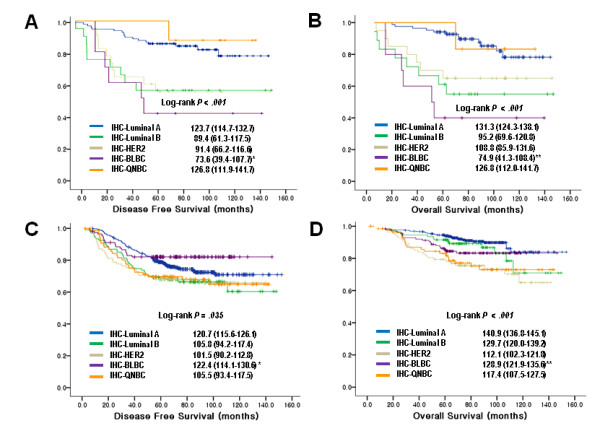
Association between chemotherapy and five-subtypes of breast cancers. Kaplan-Meier curves of disease-free survival (A and C) and overall survival (B and D). Cases without chemotherapy (A and B) and with chemotherapy (C and D) (Estimated mean survival with 95% CI). *P = 0.001, **P < 0.001